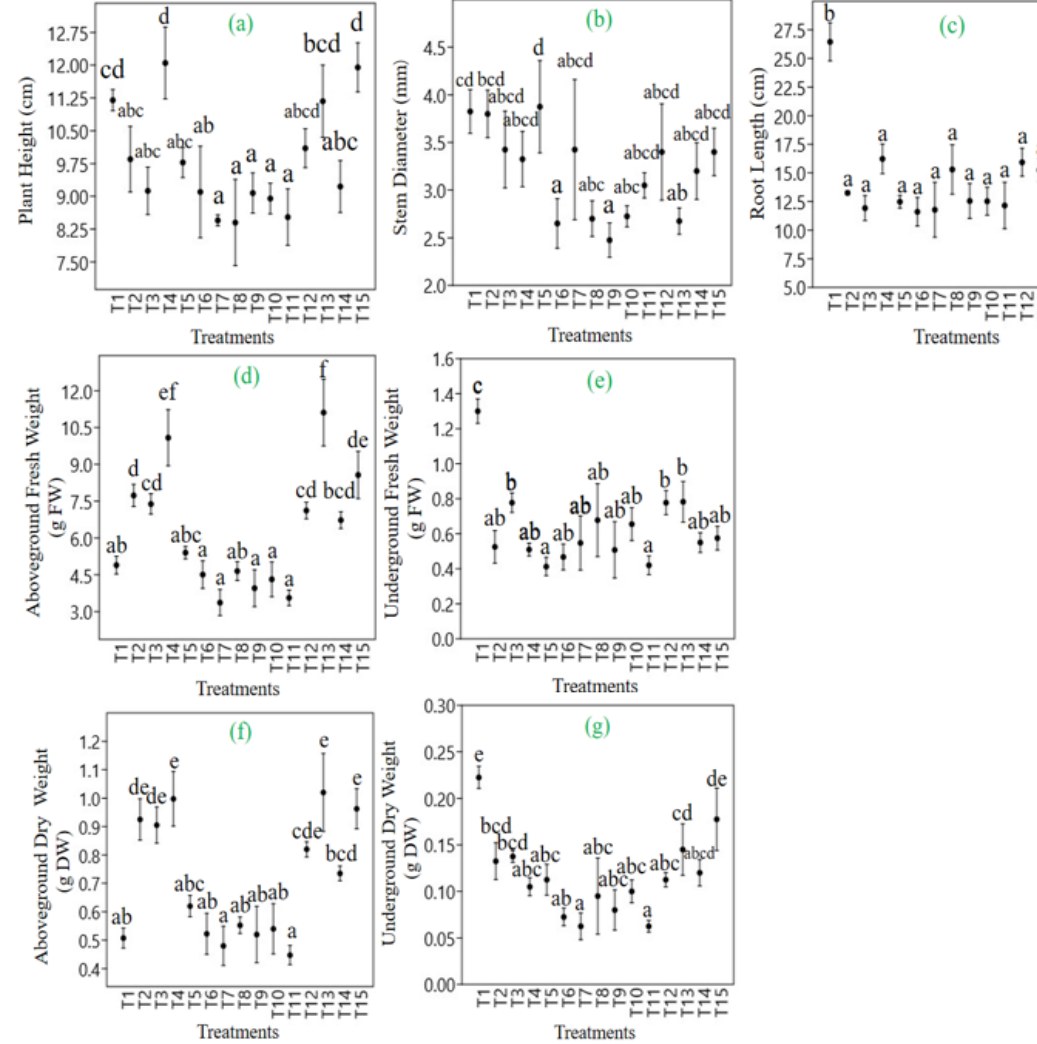
Figure 2. The ration effects of nitrogen, phosphorus, and potassium on plant height ( a ), stem diameter ( b ), root length ( c ), fresh weight ( d , e ) and dry weight ( f , g ) after four weeks treatments. (Note, T1: N-P-K=0-0-0, T2: N-P-K=0-2-2, T3: N-P-K=1-2-2, T4: N-P-K=2-0-2, T5: N-P-K=2-1-2, T6: N-P-K=2-2-2, T7: N-P-K=2-3-2, T8: N-P-K=2-2-3, T9: N-P-K=2-2-0, T10: N-P-K=2-2-1, T11: N-P-K=3-2-2, T12: N-P-K=1-3-2, T13: N-P-K=1-1-2, T14: N-P-K=1-2-1, T15: N-P-K=2-1-1; 1 unit means 0.5 g/L nutrient; Error bars indicate standard error of the mean; Different letters indicate the significant differences with p < 0.05.).